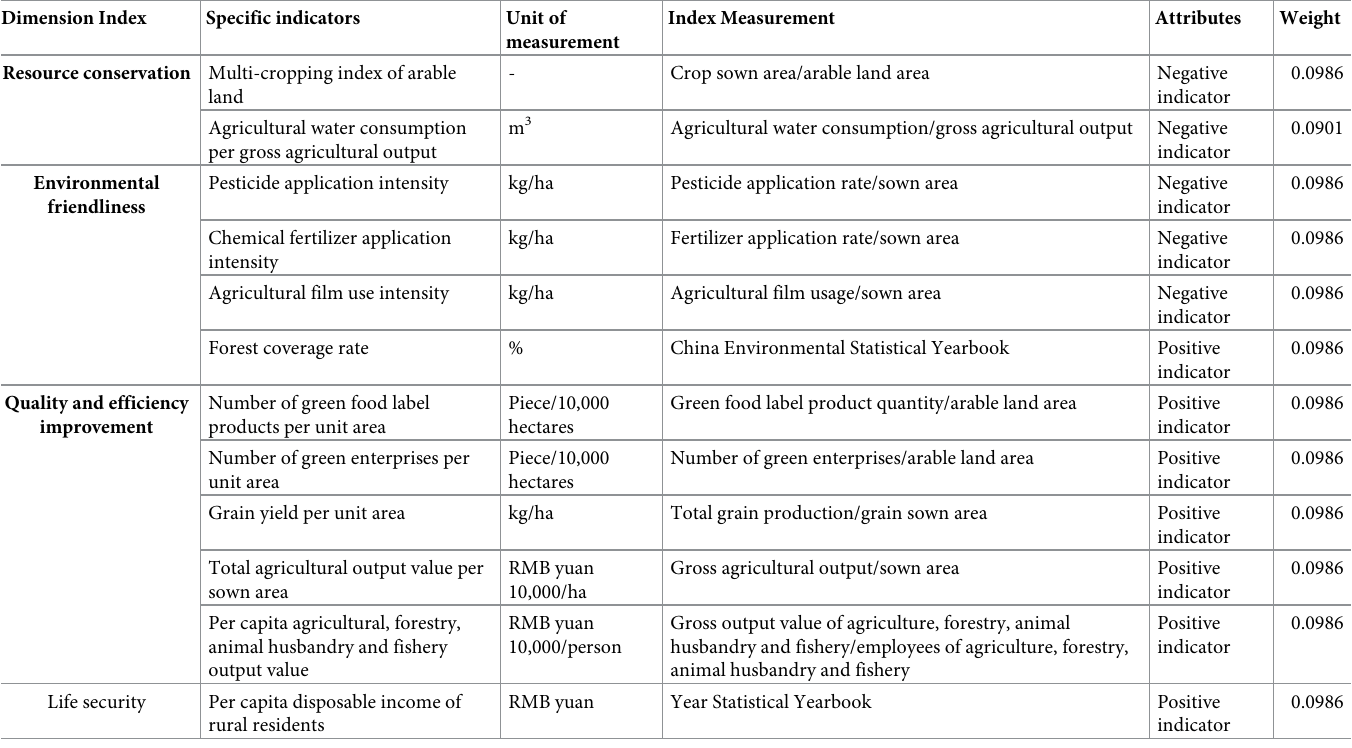
Table 3. Evaluation index system and weight of agricultural green development